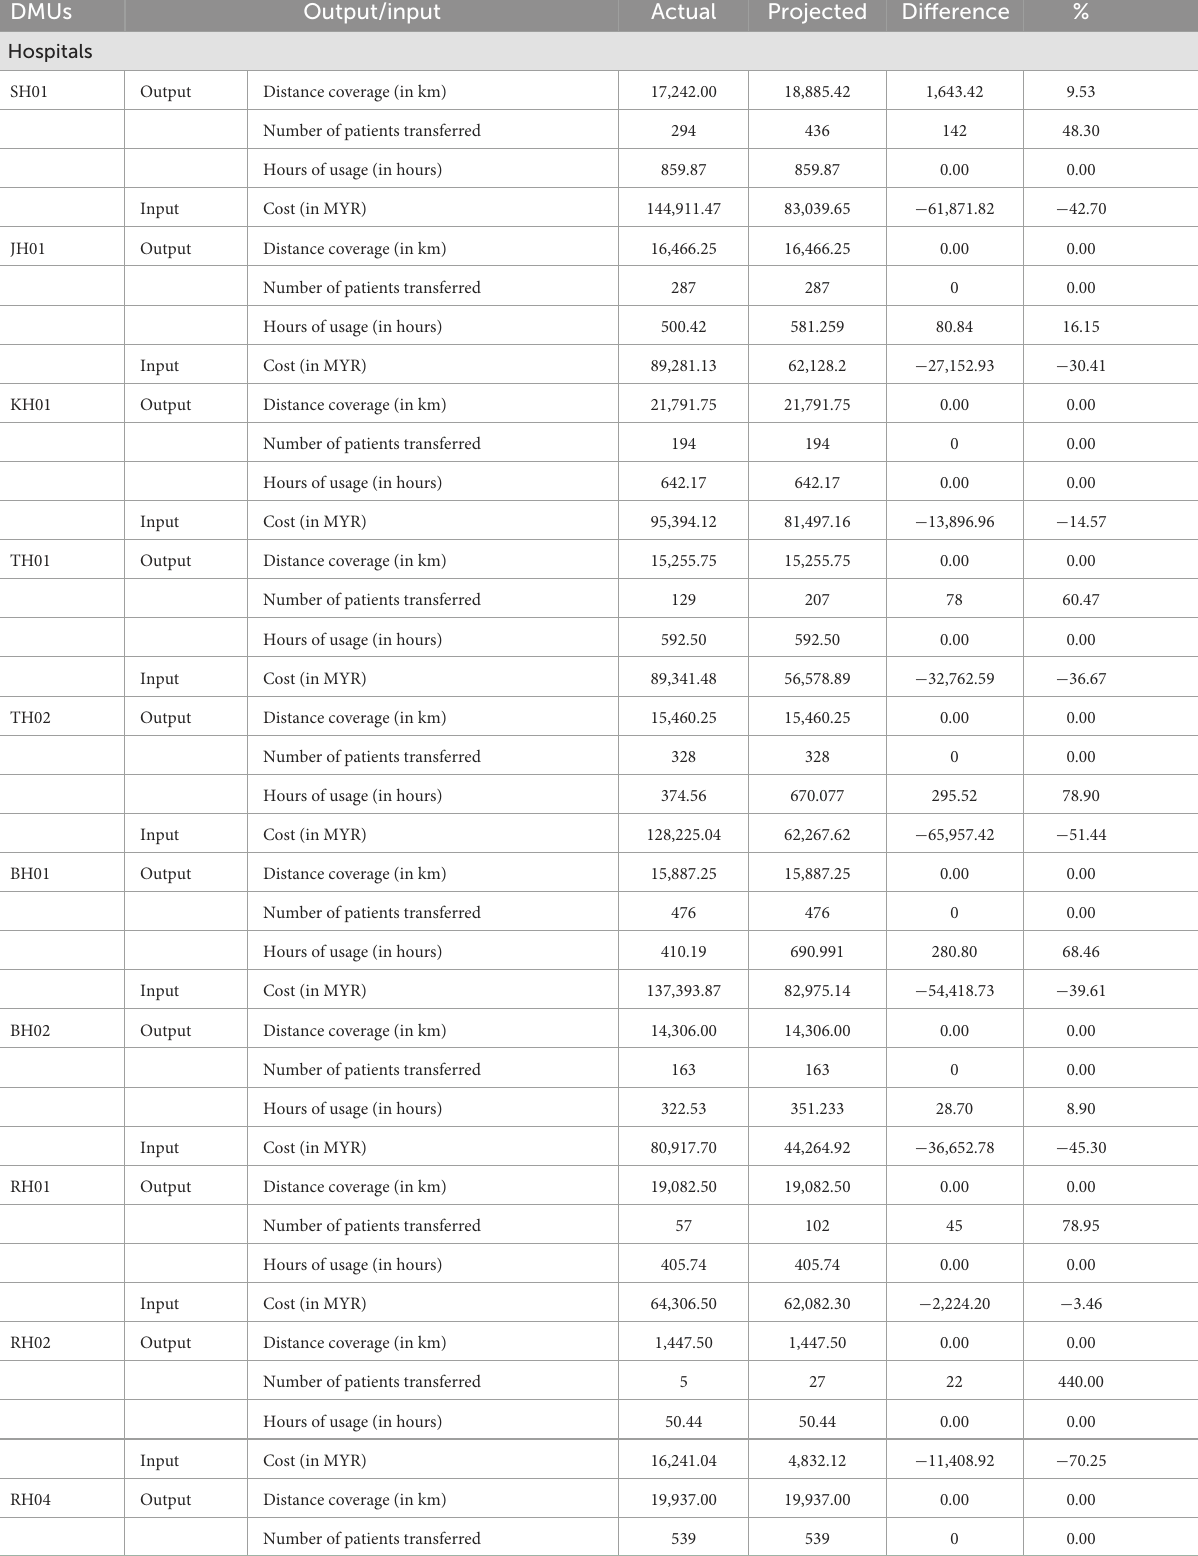
TABLE 3 Projected outputs and input for ambulance services for pure technical inefficient DMUs ( n = 65).